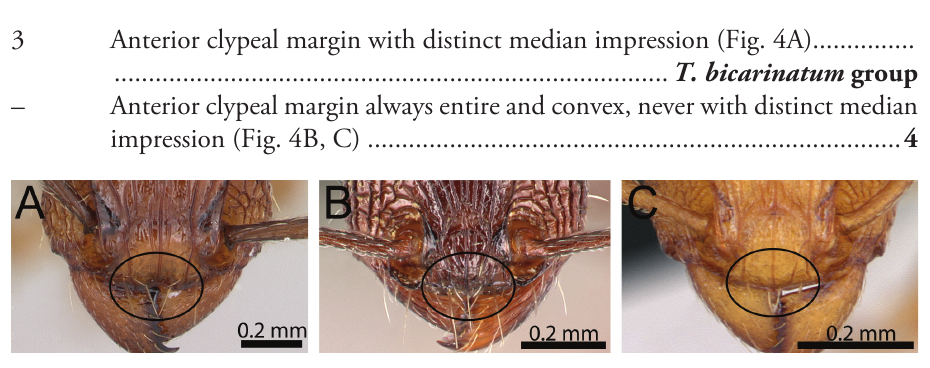
Figure 4. Anterior head in dorsal view (anterior clypeal margin within black ellipses). A T. bicarinatum